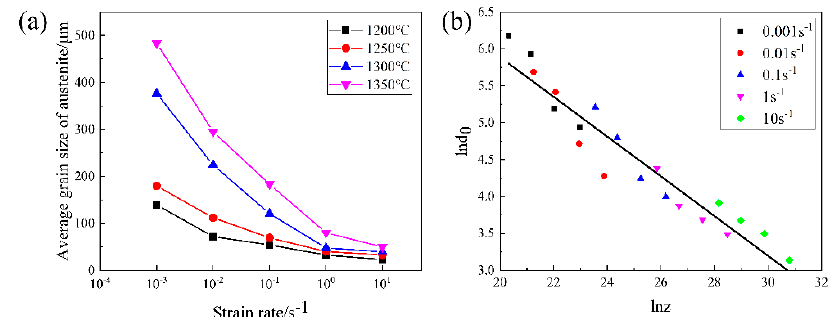
Figure 12. The relationship between d 0 and Z parameters ( a ) statistical results of dynamic recrystal- lization grain size; ( b ) ln d 0 -ln Z .